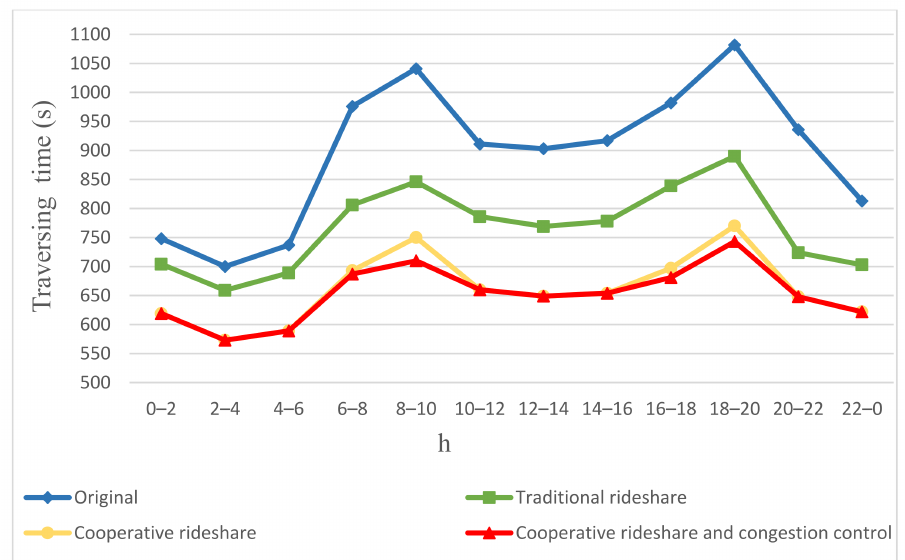
Figure 15. Traveling times of PEV/SAEV users for four different scenarios.